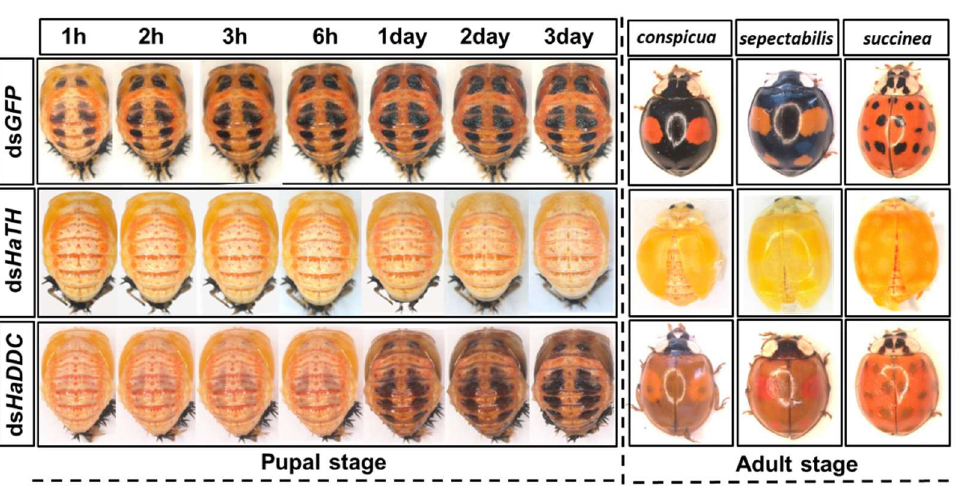
Figure 3. The phenotypes of abnormal pupae and adults from the fourth instar larvae of H. axyridis injected with ds HaTH and ds HaDDC , respectively.